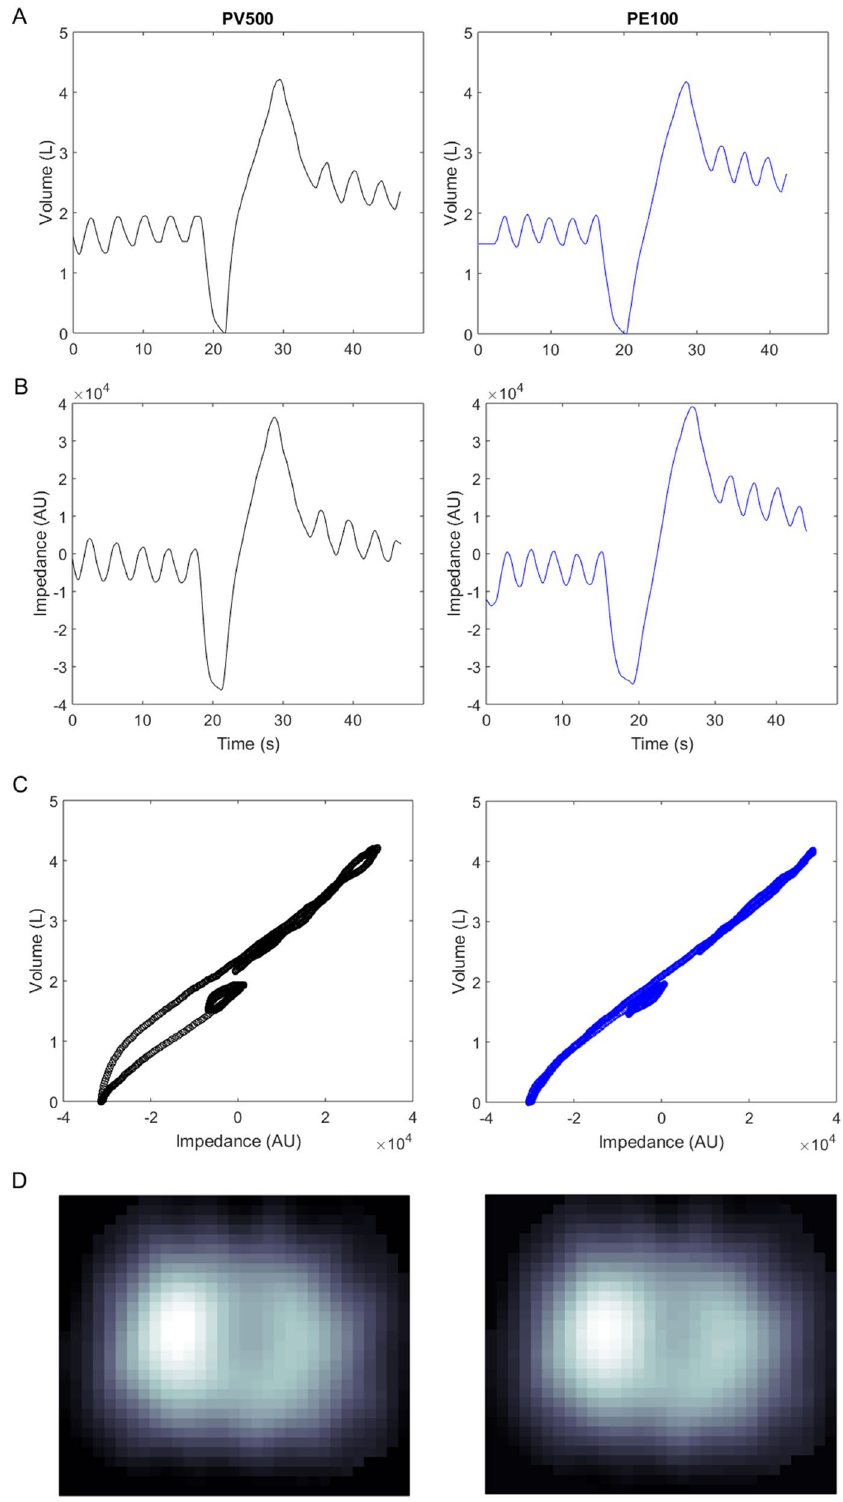
Figure 4. Illustration of the measurement sequence and relative impedance changes. First row, relax tidal breaths and slow vital capacity maneuvers recorded with a spirometer. Second row, impedance-time curves during the SVC maneuver. Third row, correlation between the spirometry volume and EIT impedance changes. Fourth row, impedance variation during SVC. AU, arbitrary unit. PV500 PulmoVista 500, PE100